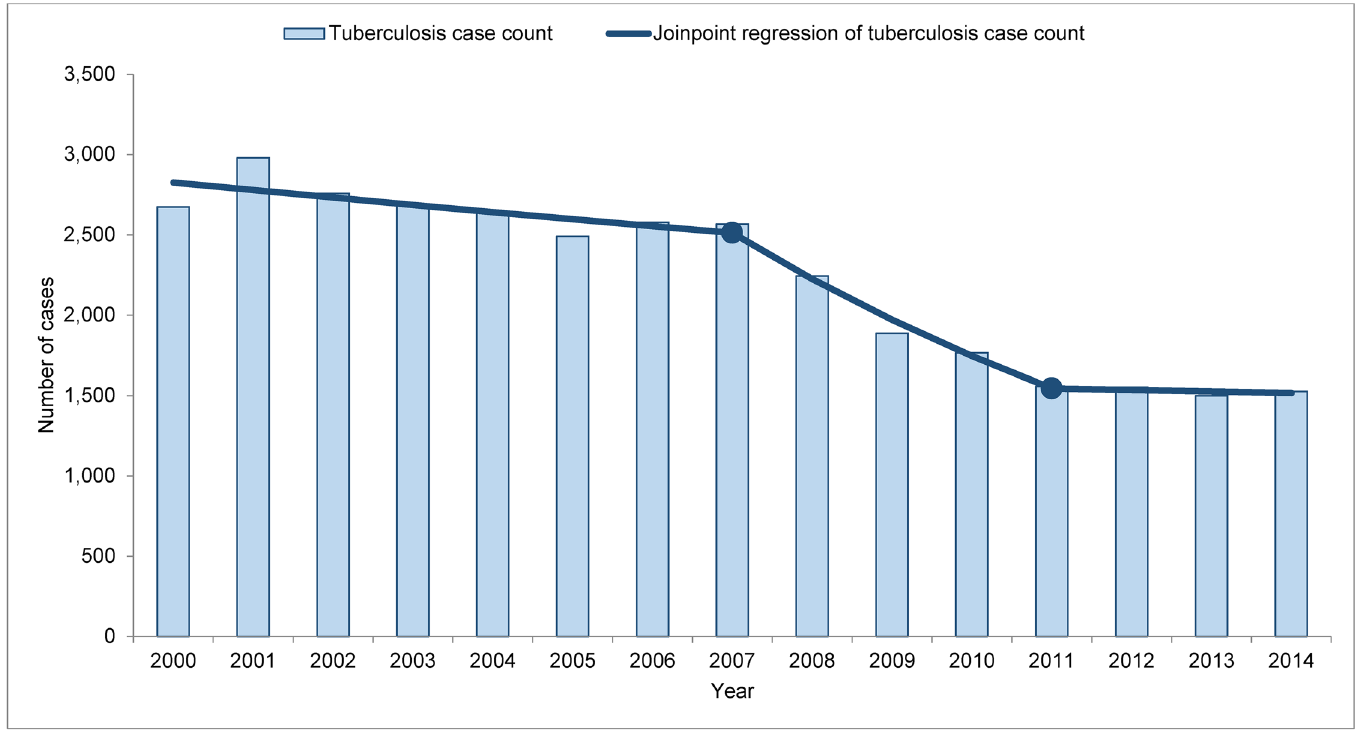
Fig 1. Tuberculosis case counts with Joinpoint regression among recent entrants, 2000 – 2014. Shaded bars indicate tuberculosis case counts among recent entrants (foreign-born persons with < 3 years since U.S. entry). The solid line represents a Joinpoint regression of tuberculosis case counts. Solid circles represent statistically significant changes in trend in 2007 and 2011 (2000 – 2007 annual percent change, -1.7% [95% confidence interval {CI}, -3.5%, +0.2%); 2007 – 2011 annual percent change, -11.4% (95% CI -17.4%, -5.1%)]; 2011 – 2014 annual percent change, -0.6% [95% CI, -7.3%,